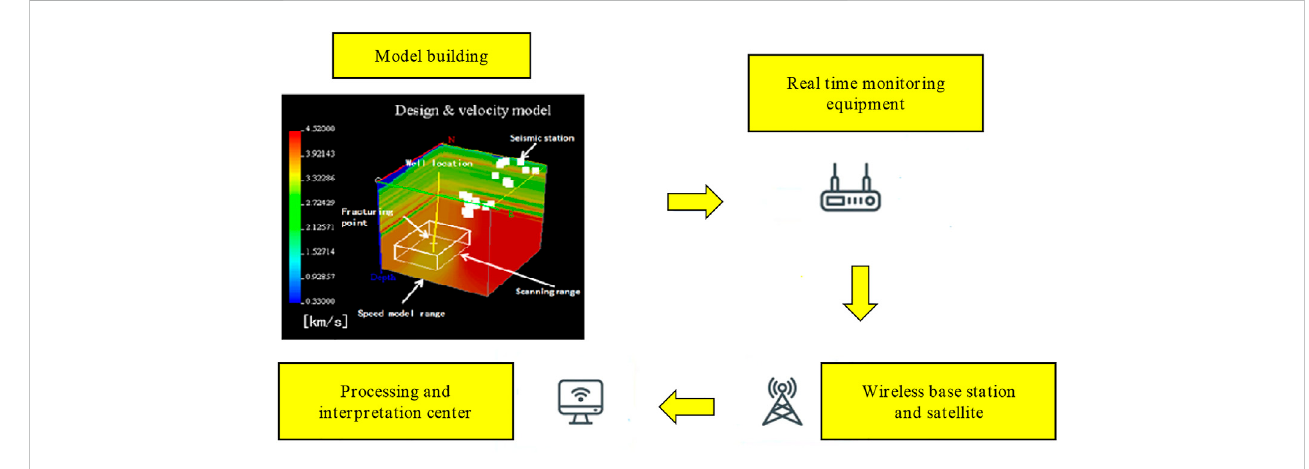
FIGURE 1 Schematic Diagram of the technical process and